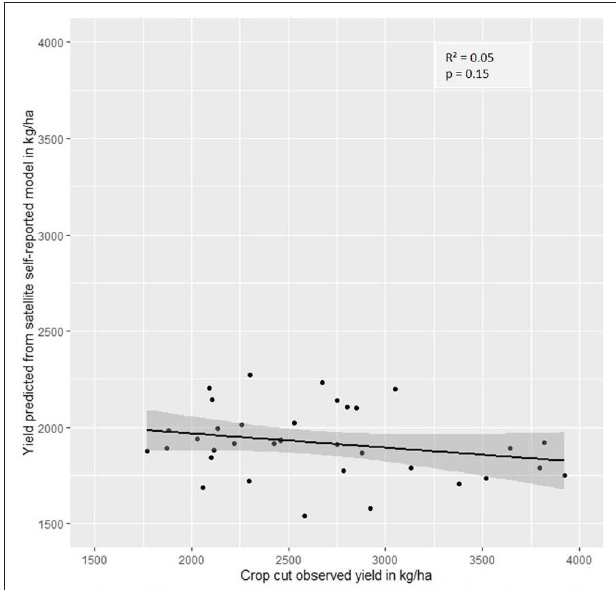
FIGURE 4 | Predicted yields using the satellite yield estimation model calibrated using self-reported data vs. crop cut observed yields. The R 2 and p values from a linear regression are reported. The gray band around the regression line represents standard